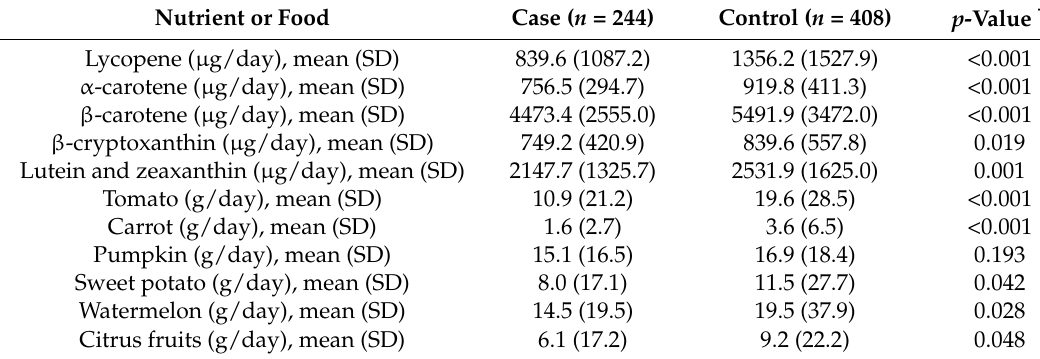
Table 2. Comparison of the intakes of carotenoids and their major sources between cases and